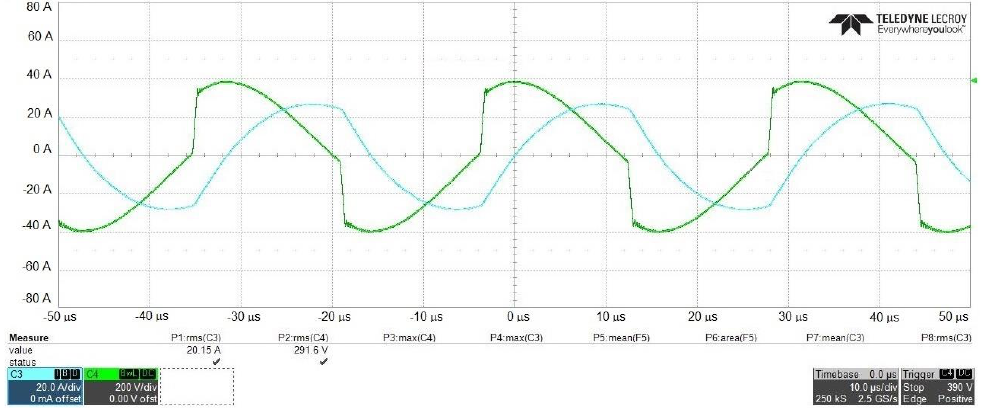
Figure 25. Transmitter coil voltage (C4, green) and current (C3, blue) at 39 kHz.